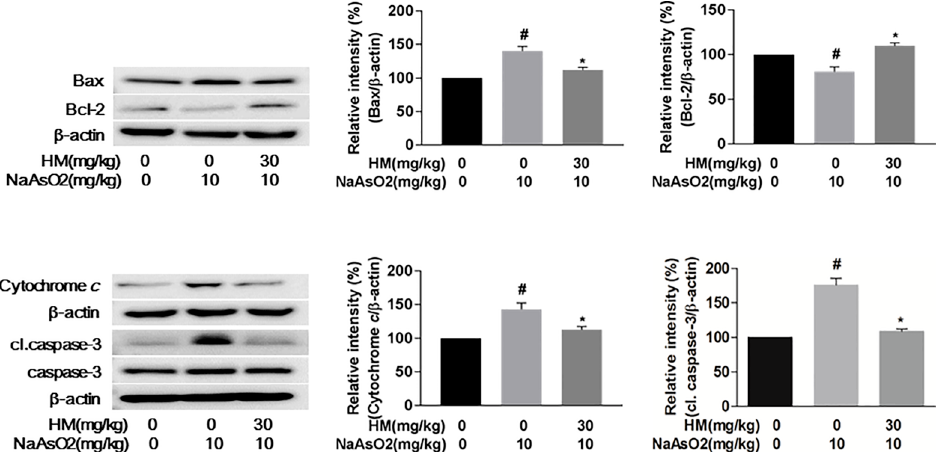
Figure 7. Effect of HM on the apoptotic signaling pathways in response to NaAsO 2 and HM exposure. The expression of Bcl-2-associated X protein (Bax), B-cell lymphoma-2 (Bcl-2), cytochrome c , and caspase-3 in liver tissue was analyzed by Western blot analysis. Co-treatment with HM effectively regulated the Bax/Bcl-2 ratio and notably downregulated the expression of cytochrome c , and cleaved caspase-3. Data are expressed as mean ± standard error mean (SEM) of three independent experiments. # p < 0.05 compared with the control and NaAsO 2 group, and * p < 0.05 compared with the NaAsO 2 and HM extract-treated group.